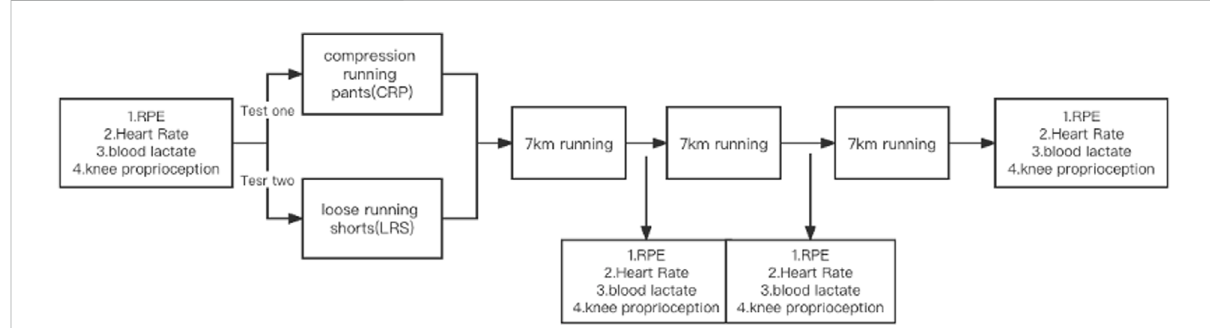
FIGURE 1 The experimental process. The study included two trials, in which each participant ran 21 km. The total distance of each run was 21 km, broken into three 7 km stages. Heart rate, RPE, and blood lactic acid were monitored, and knee fl exion proprioception was tested for each participant over the stages of the